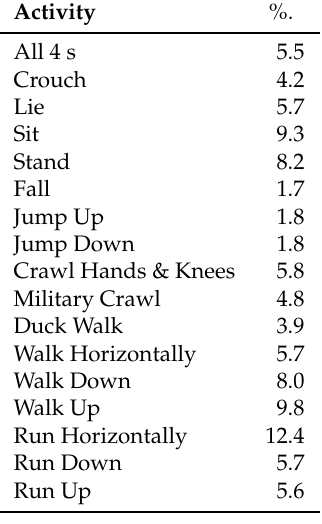
Table 1. The 17 activities and the proportion (%) with which they are represented in the data-set. Activity